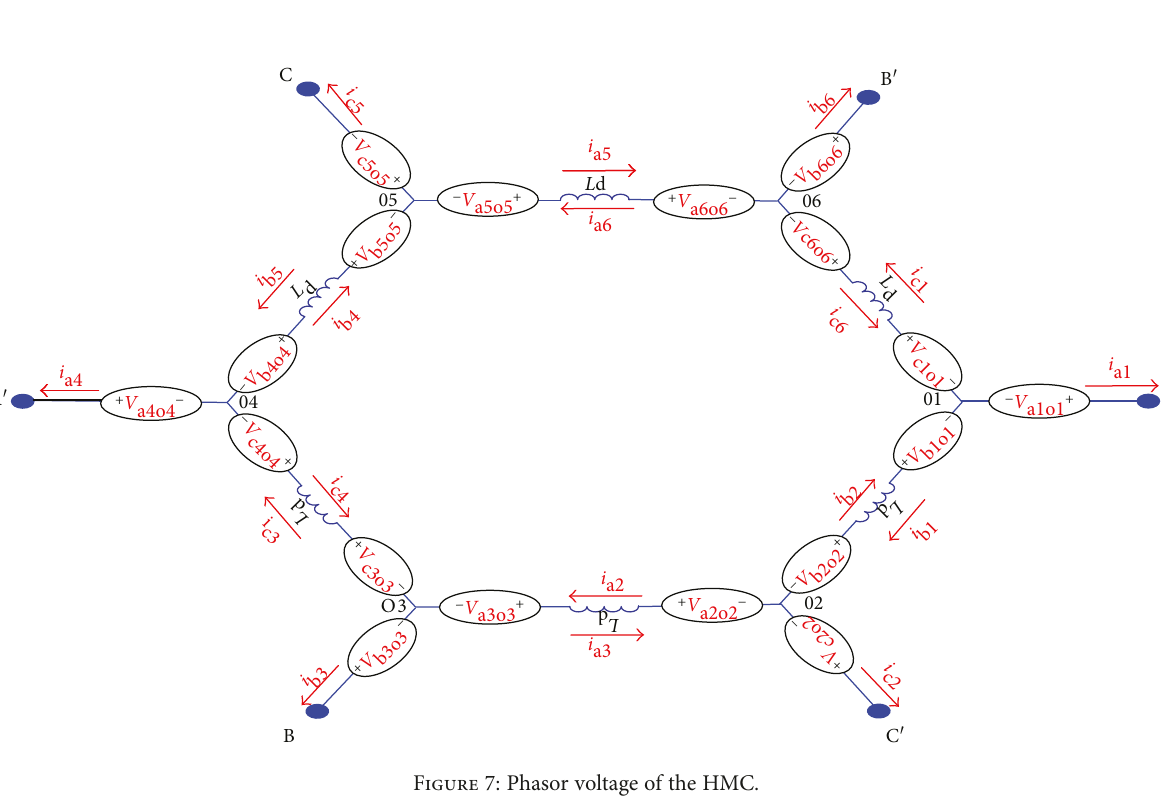
Figure 7: Phasor voltage of the